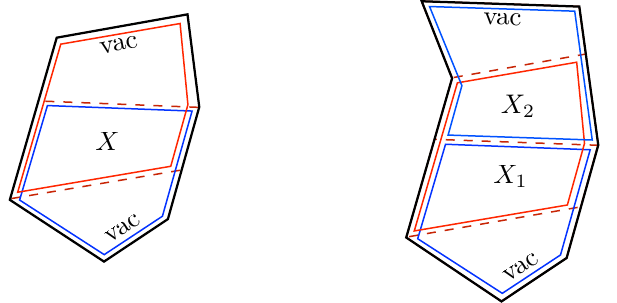
Figure 5 . Decomposition of hexagon and heptagon Wilson loops into overlapping sequences of pentagons. For the hexagon, we have two pentagons overlapping on one square and correspondingly only one complete sum over intermediate states is needed. The heptagon has an extra hat, one more pentagon and middle square, and two sums are